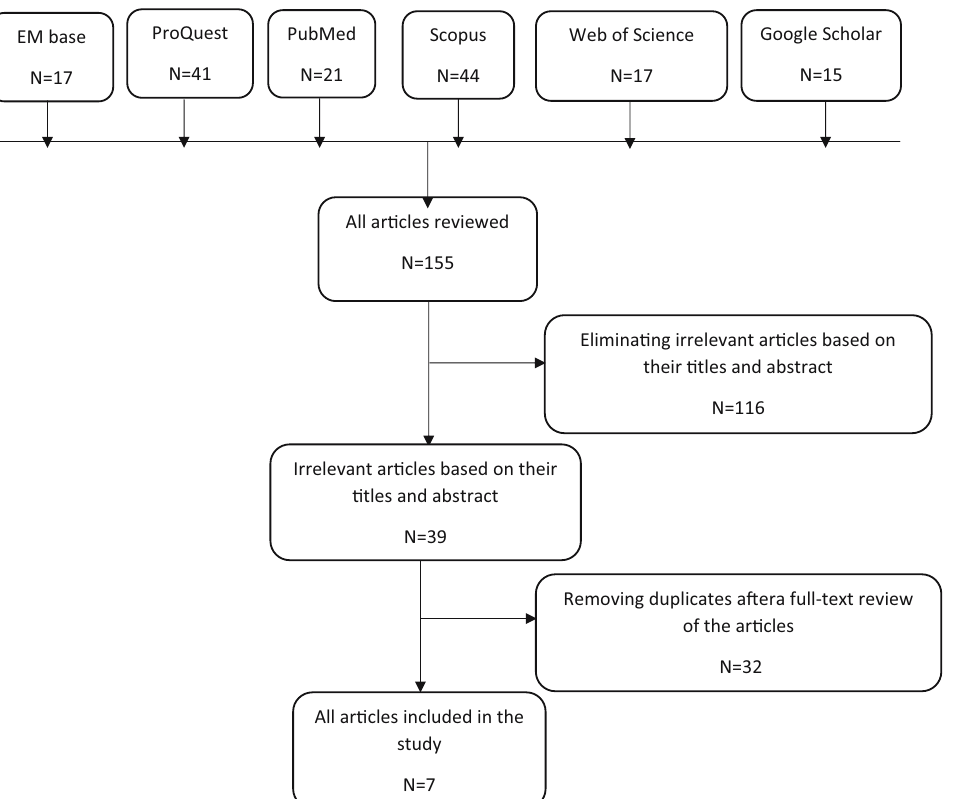
Figure 1: Search fl ow